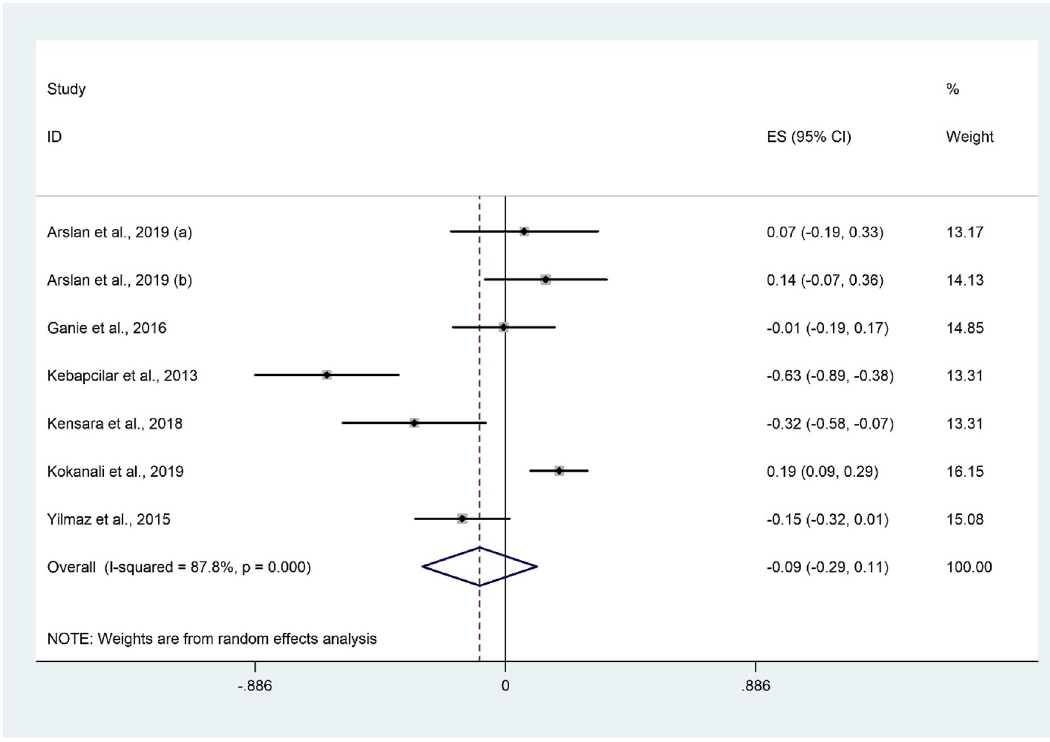
Figure 9. Forrest plot of the correlation between LH and 25(OH)D level.